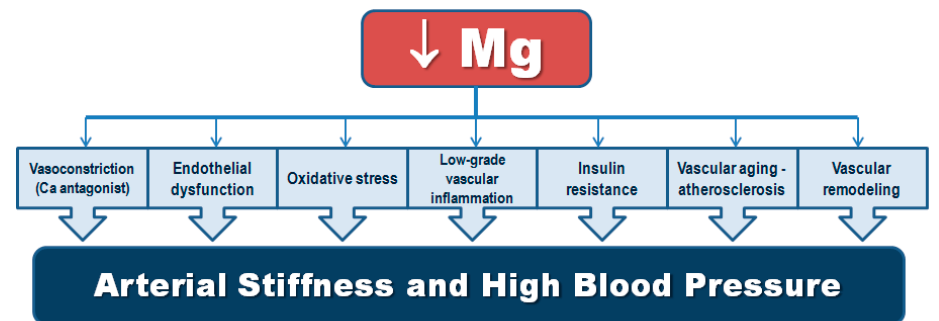
Figure 2. Combination of effects of magnesium by which magnesium deficit may lead to Figure 2. C ombination of effects of magnesium by which magnesium deficit may lead to hyperten- sion.